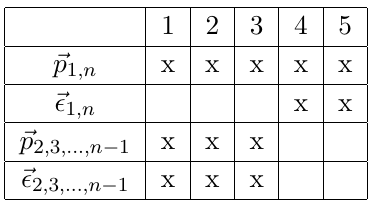
Table 1 . Kinematic con(cid:12)guration of momenta and polarizations of BI 6 de(cid:12)ning mDBI 4 and for YM 6 de(cid:12)ning (YM + mAdj) 4